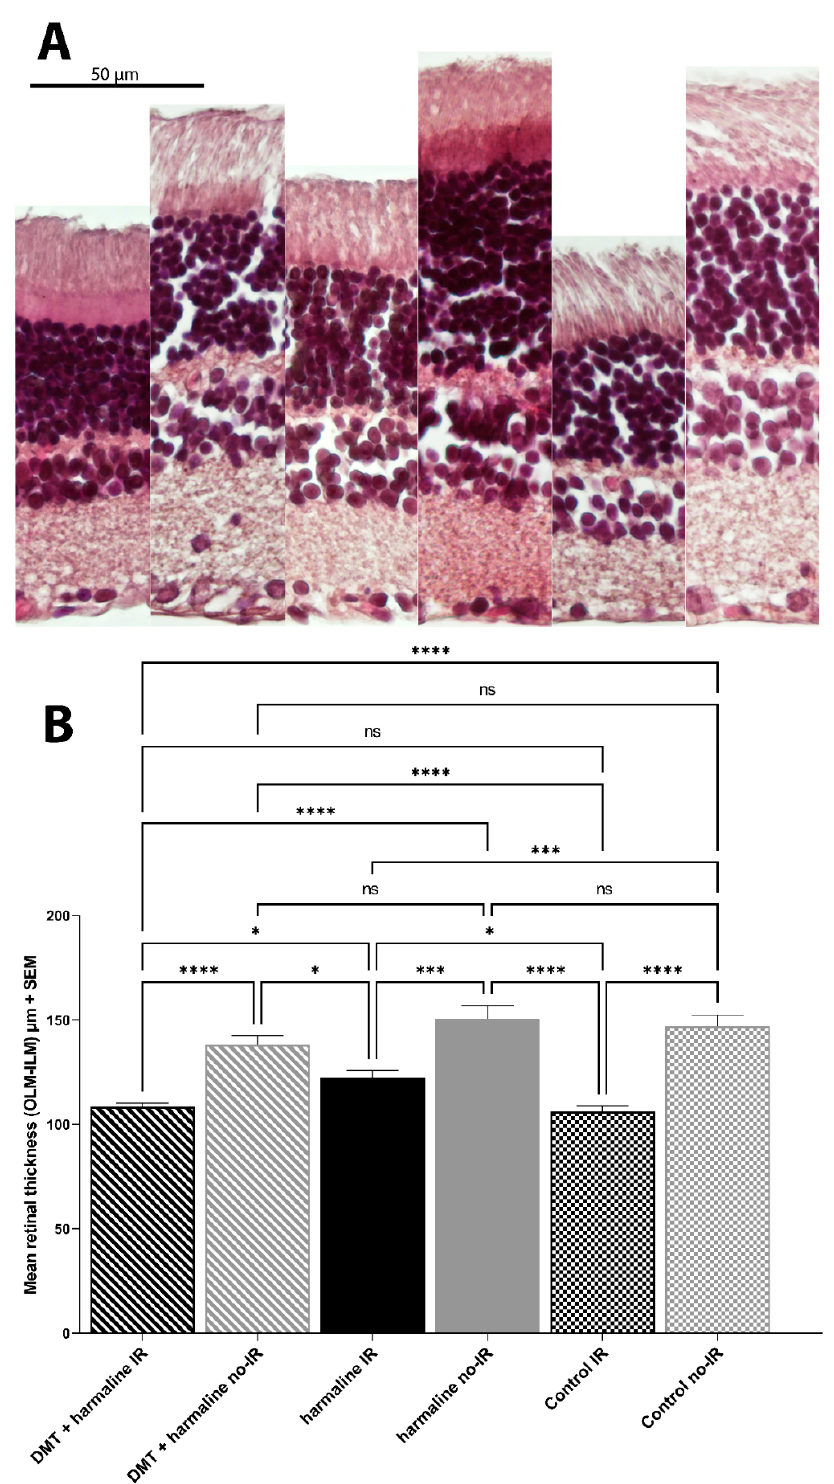
Figure 6. Retinal thickness in the different treatment groups. ( A ): Representative images of retinal thickness in the different treatment groups as seen under the microscope during histological analysis. ( B ): Graph of group mean retinal thickness as measured in sections of the different treatment groups during histological analysis. The order of the sections and the graphs are identical. All results are plotted as mean percentages + SEM. ns = non-significant; * = p < 0.05; *** = p < 0.001; **** = p < 0.0001.